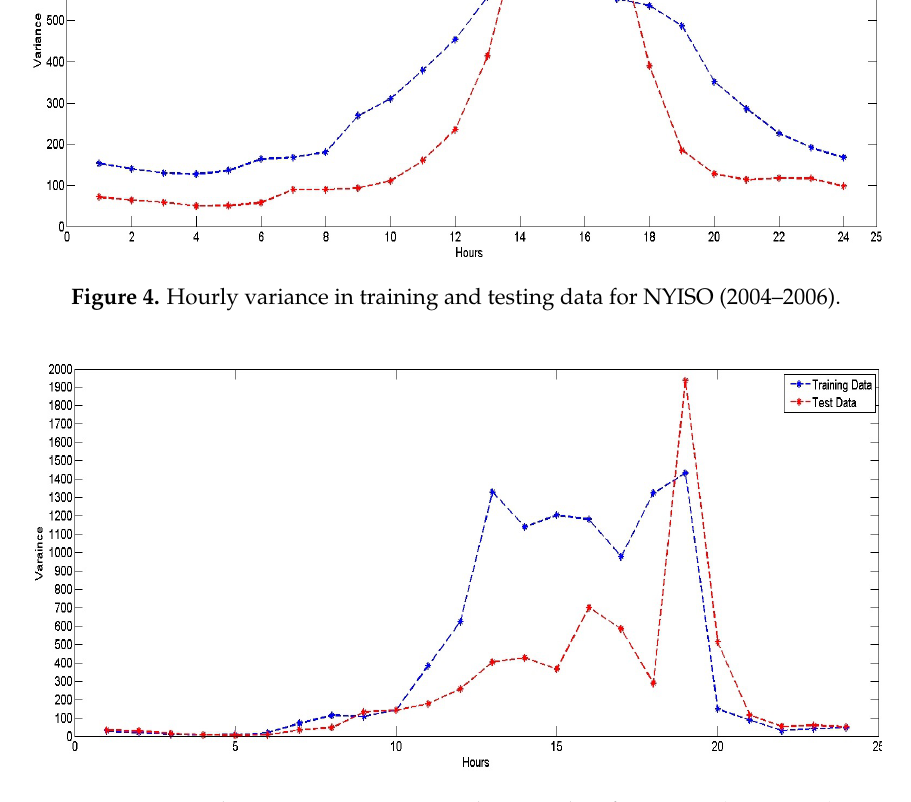
Figure 5. Hourly variance in training and testing data for ANEM (2004–2006).